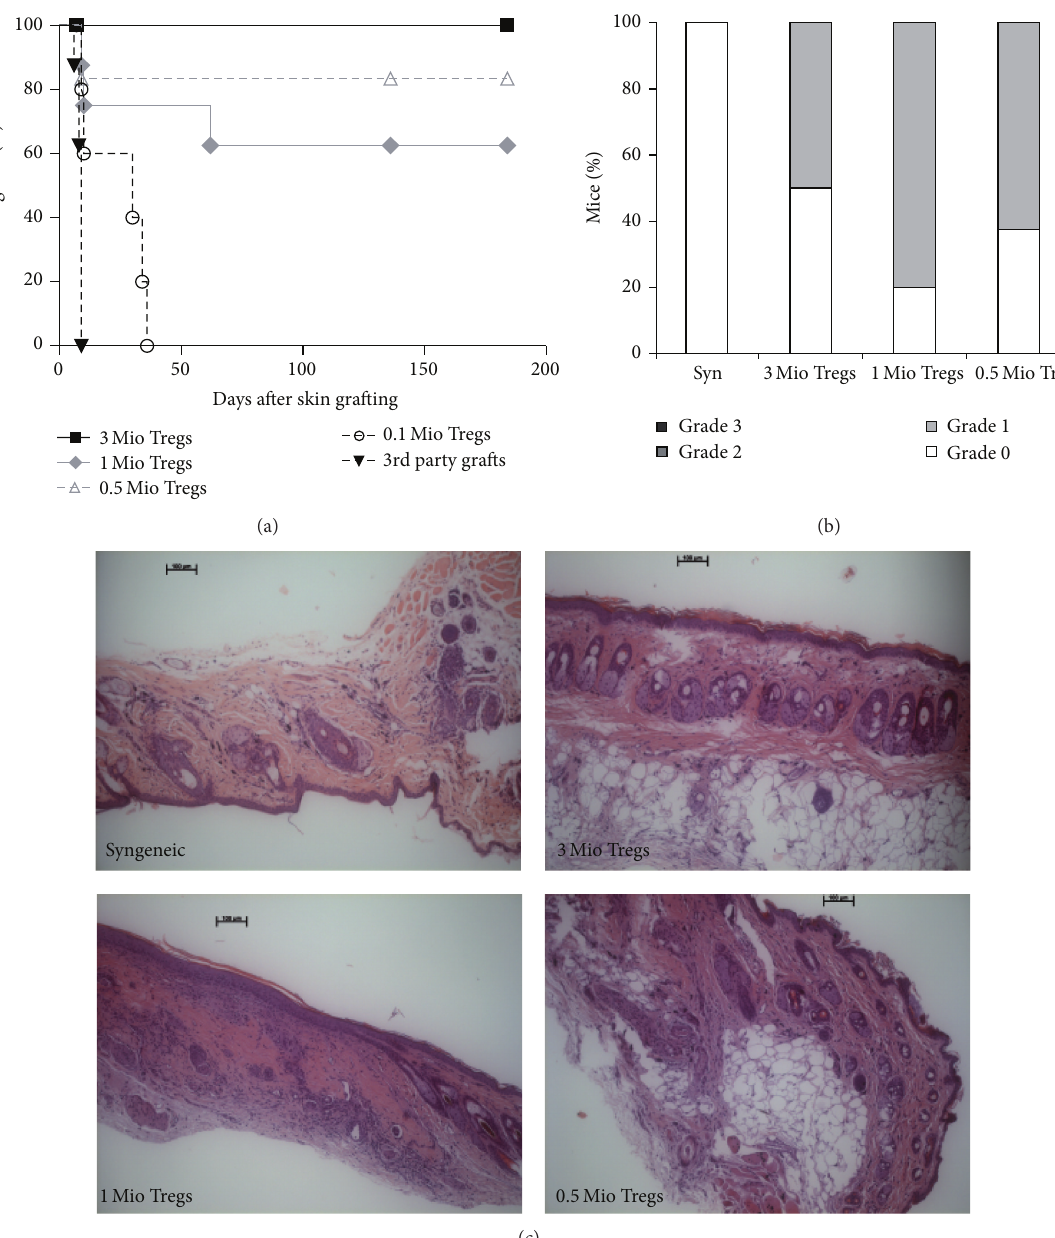
Figure 3: Tolerance is successfully induced in chimeras that received low-dose Treg therapy. Donor-specific tolerance was assessed by grafting of donor and third-party skin 4–6 weeks after BMT. (a) Donor skin graft survival was significantly prolonged in BMT recipients treated with Treg numbers that have been shown to be sufficient to induce chimerism ( ◼ 3 × 10 6 cells, 𝑛 = 4 ; X 1 × 10 6 cells, 𝑛 = 8 ; 󳵻 0.5 × 10 6 cells, 𝑛 = 6 ; I 0.1 × 10 6 cells, 𝑛 = 6 ; 󳶃 pooled third-party grafts, 𝑛 = 24 ). Survival was calculated according to the Kaplan-Meier product limit method and compared between groups using the log-rank test ( 𝑝 < 0.05 for 0.1 × 10 6 cells versus each other group). (b) Classification of skin allograft pathology for syngeneic grafts ( 𝑛 = 4 ) and Treg treated groups (3 × 10 6 cells, 𝑛 = 8 ; 1 × 10 6 cells, 𝑛 = 8 ; 0.5 × 10 6 cells, 𝑛 = 5 ; 0.1 × 10 6 cells, 𝑛 = 8 ) are shown [22] (Grade 0: no or rare inflammatory infiltrates, skin architecture intact; Grade 1: mild inflammatory infiltration, no involvement of overlying epidermis; Grade 2: moderate perivascular inflammation with mild epidermal/adnexal involvement; Grade 3: severe inflammation, atrophy of epidermis, dyskeratosis, and/or keratinolysis). Data are representative for at least 2 independent experiments per group. (c) Representative histology from skin grafts of Treg treated groups and syngeneic controls ( > 120d after skin grafting; HE staining magnification × 100) is